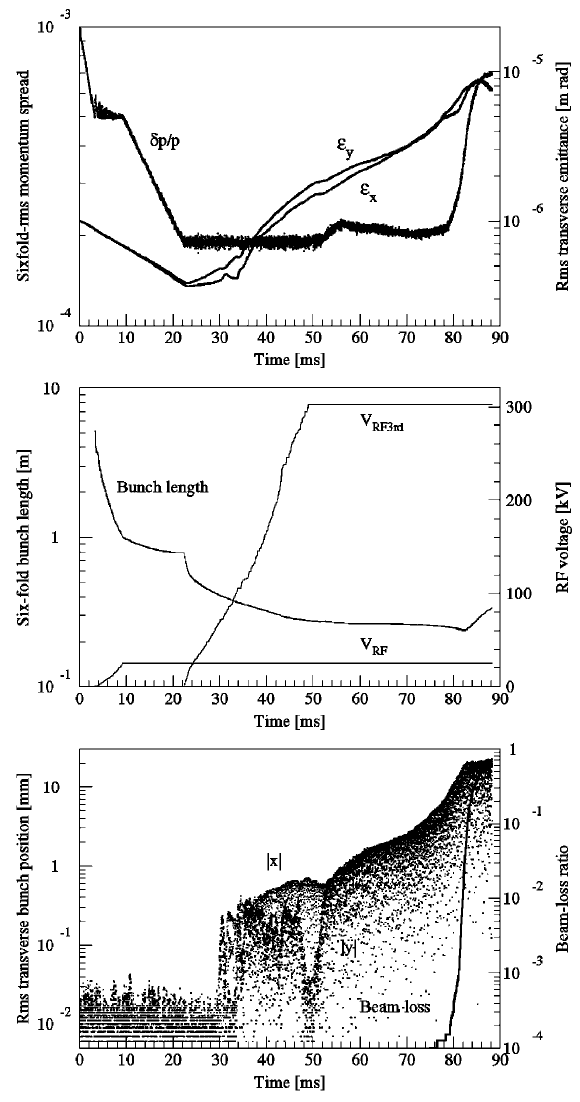
FIG. 1. Time evolution of the 238 U 92 (cid:8) beam of 4 mA during the BS.